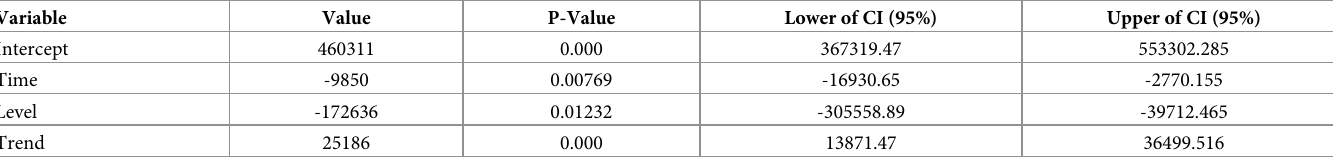
Table 1. The coefficients of the segmented regression model after Covid-19 in the public hospitals.